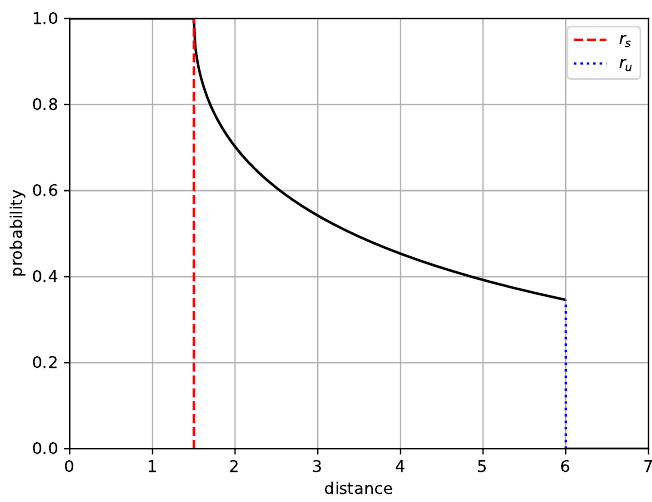
Figure 1. Example of the probabilistic sensing model with r s = 1.5 m , r u = 6 m, k = 0.5 and q =